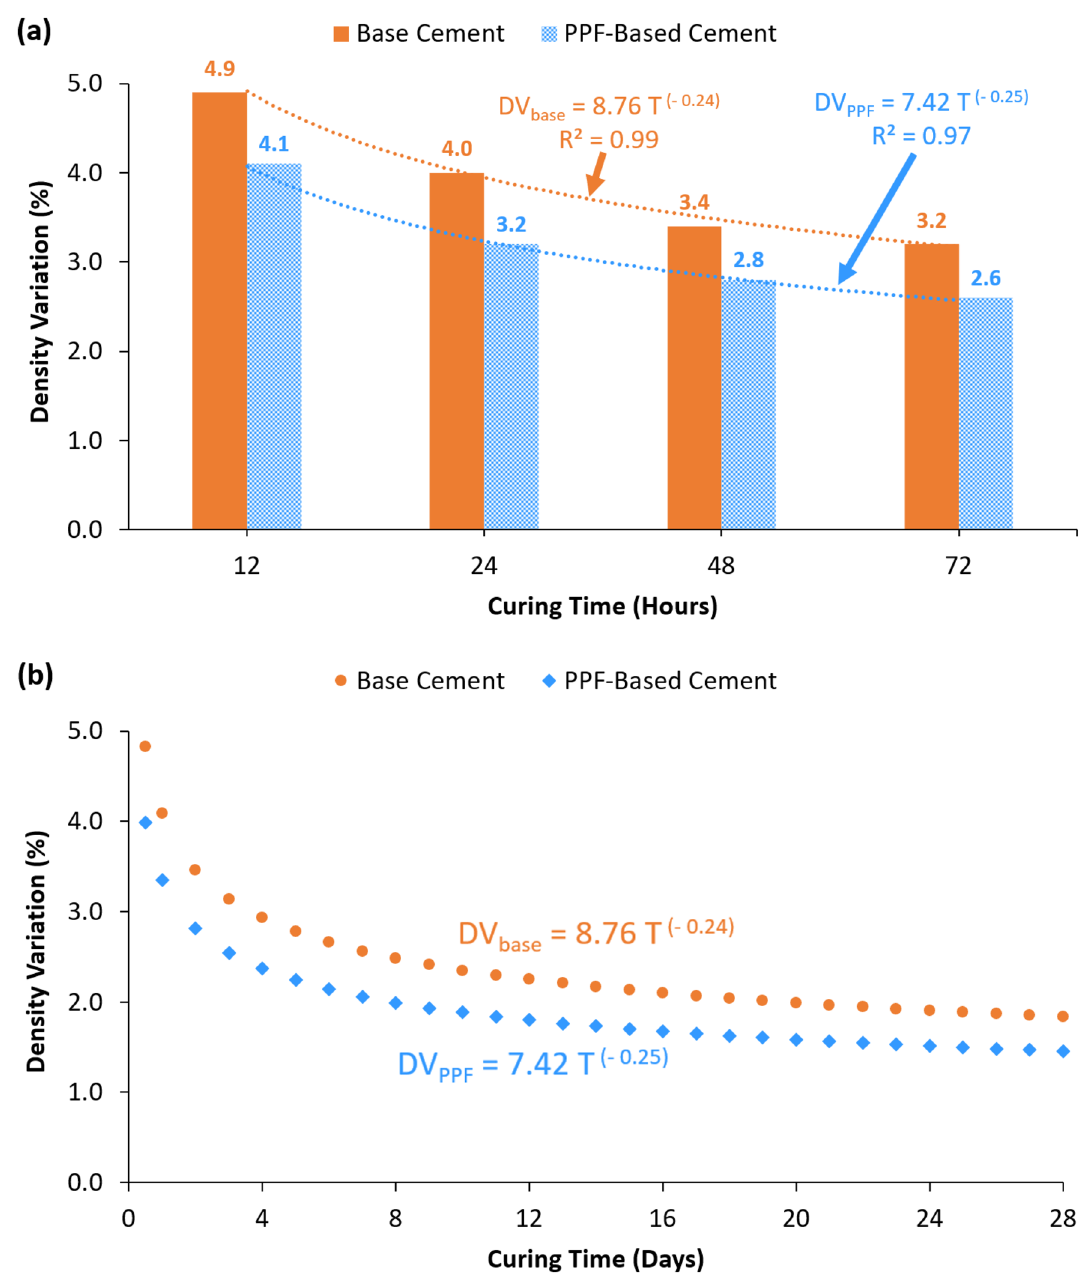
Fig. 11 Density variation for the polypropylene and base specimens at various stages of curing. a The findings of the density variation during the early curing times. b The anticipated density variation over 4